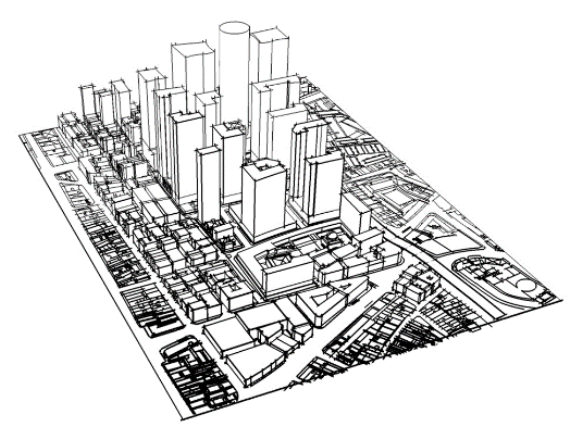
Figure 2. The proposed development that is claimed to be an example for ‘smart’ cities in